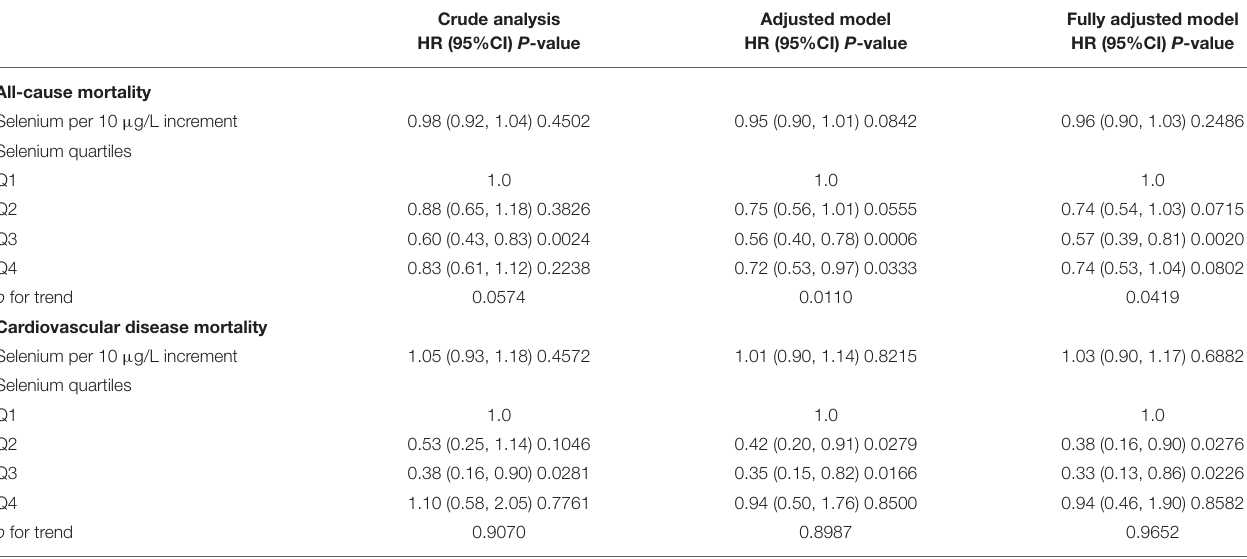
Table 3 . Taking the lowest quartiles (Q1) as reference, the full- adjusted HRs for all-cause mortality among groups (Q2,